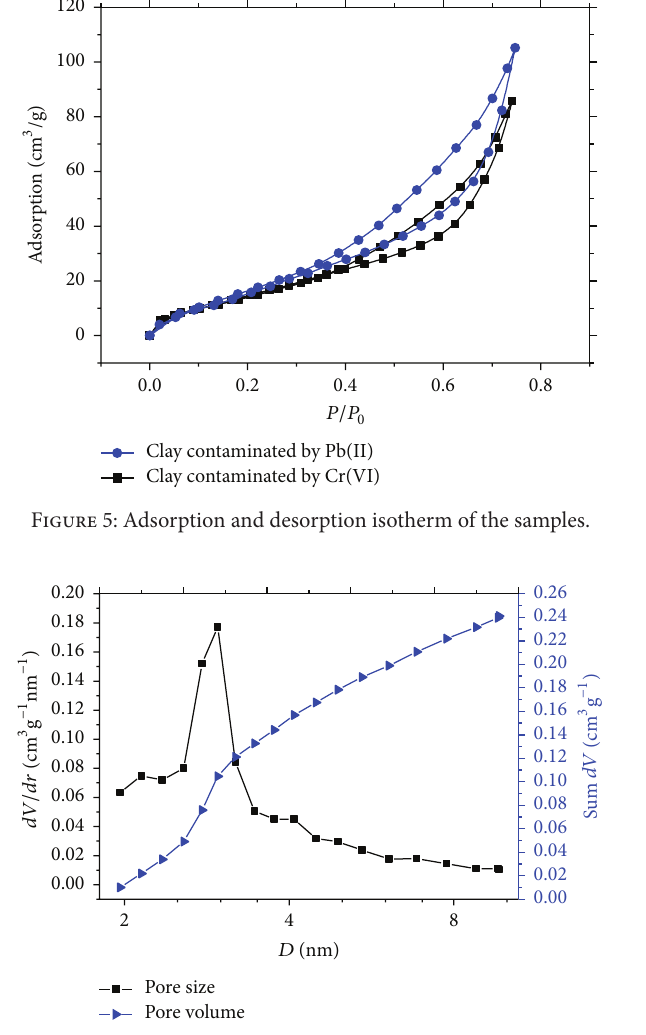
Figure 6: The pore volume and pore size distributions of modified clay ( 𝐶 0 = 0mg/L).